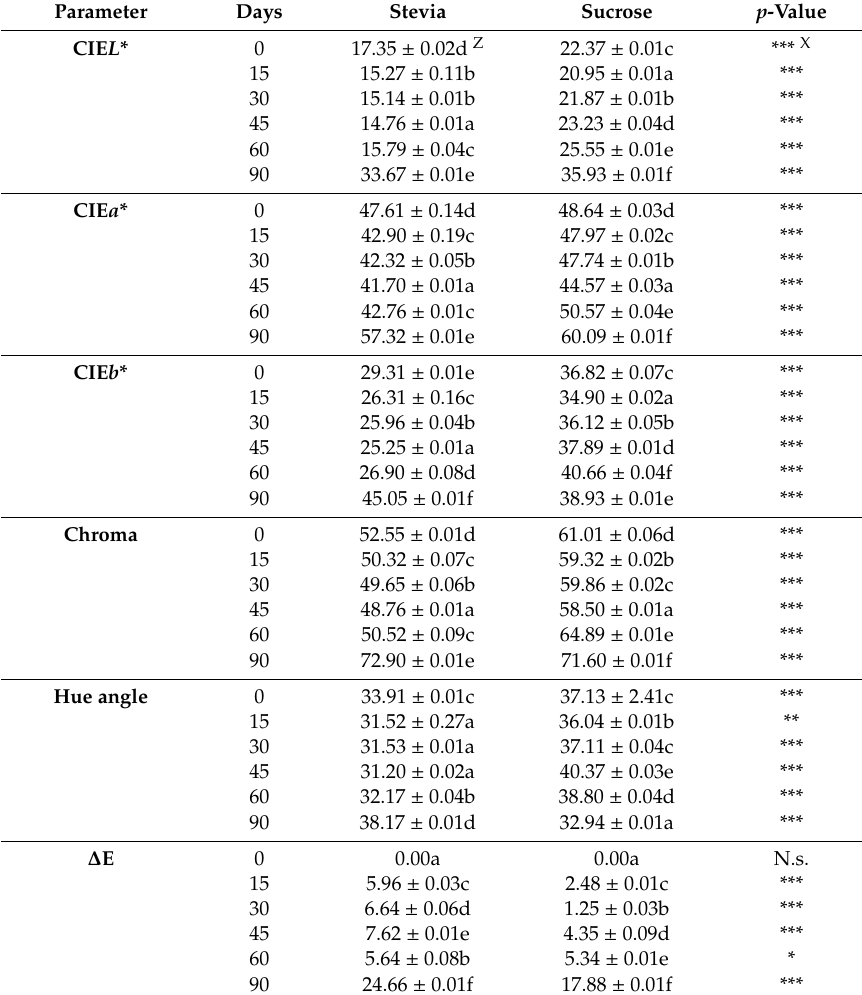
Z Means ( n = 3) within a column followed by the di ff erent lowercase letters (comparison between storage timepoints) are significantly di ff erent at p < 0.001. Within a row (sweetener comparison), values were comparing using a t -test. X Significant di ff erences at * ( p < 0.05), ** ( p < 0.01), and *** ( p < 0.001). N.s., no significant di ff erences. CIE L *, lightness; CIE a *, redness; CIE b *, yellowness; ∆ E, di ff erence or distance between two